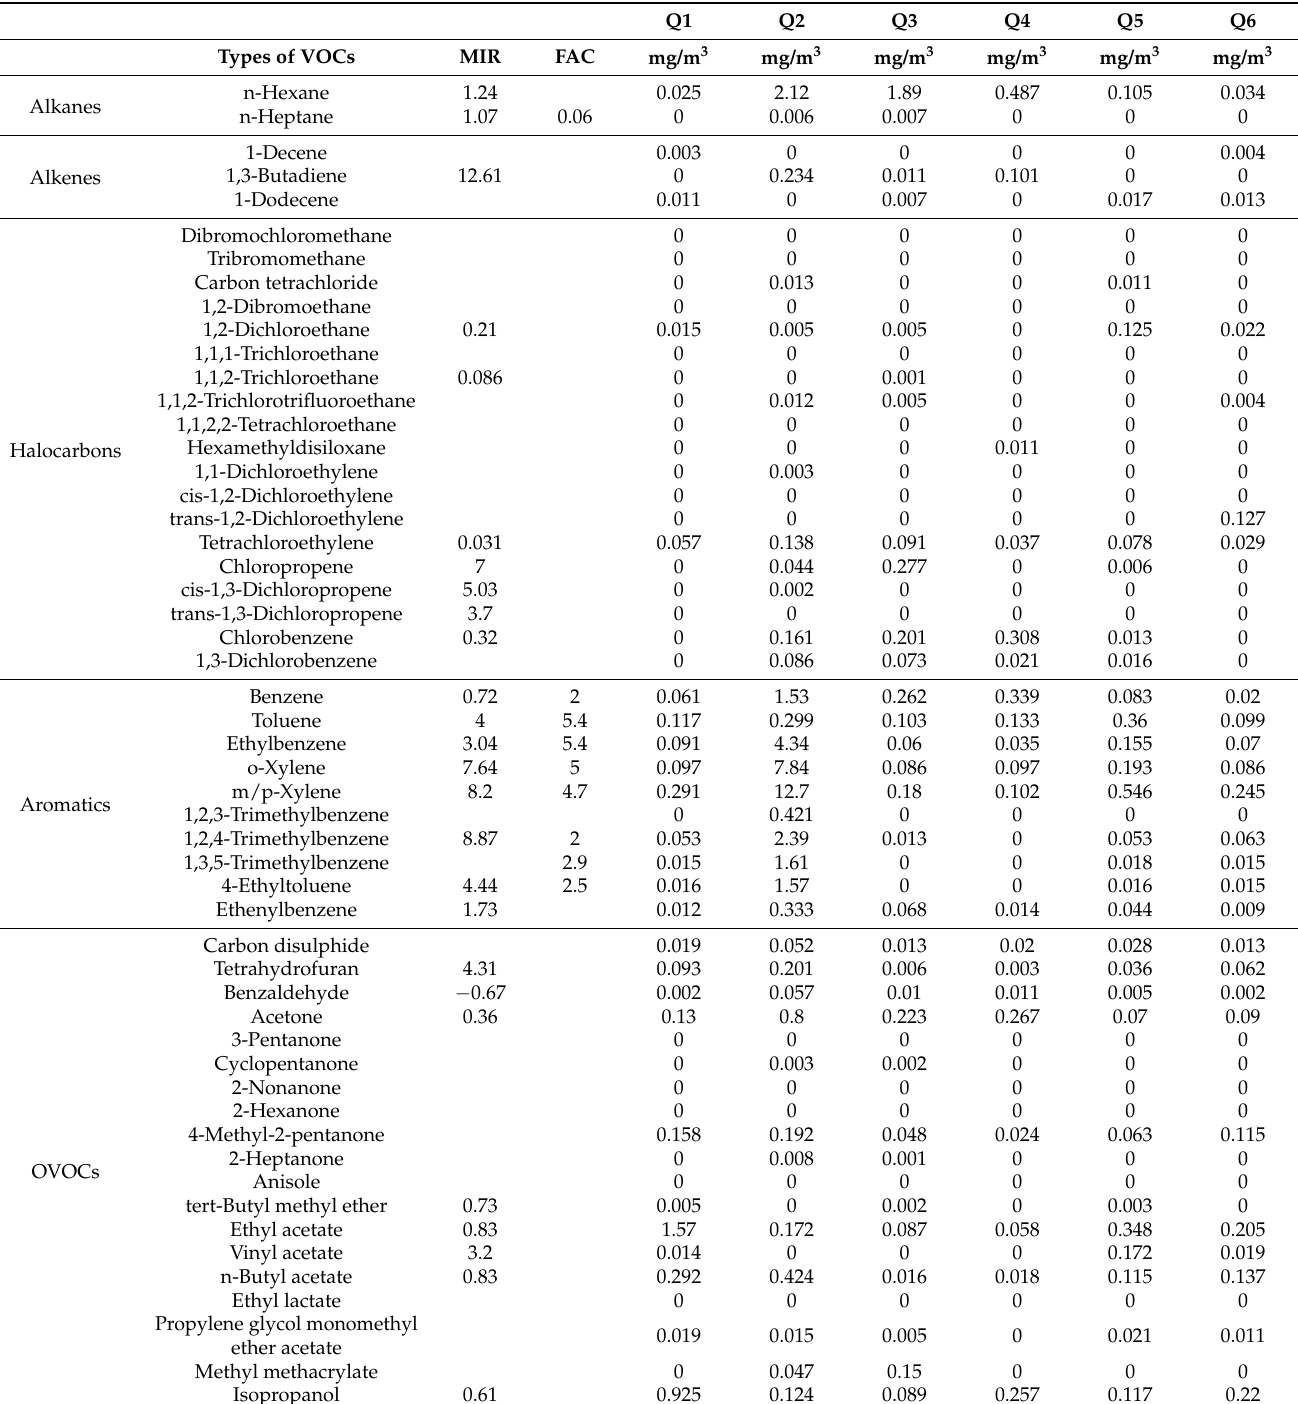
Table 1. Sample concentrations, species composition and component characteristics of the organic emissions of